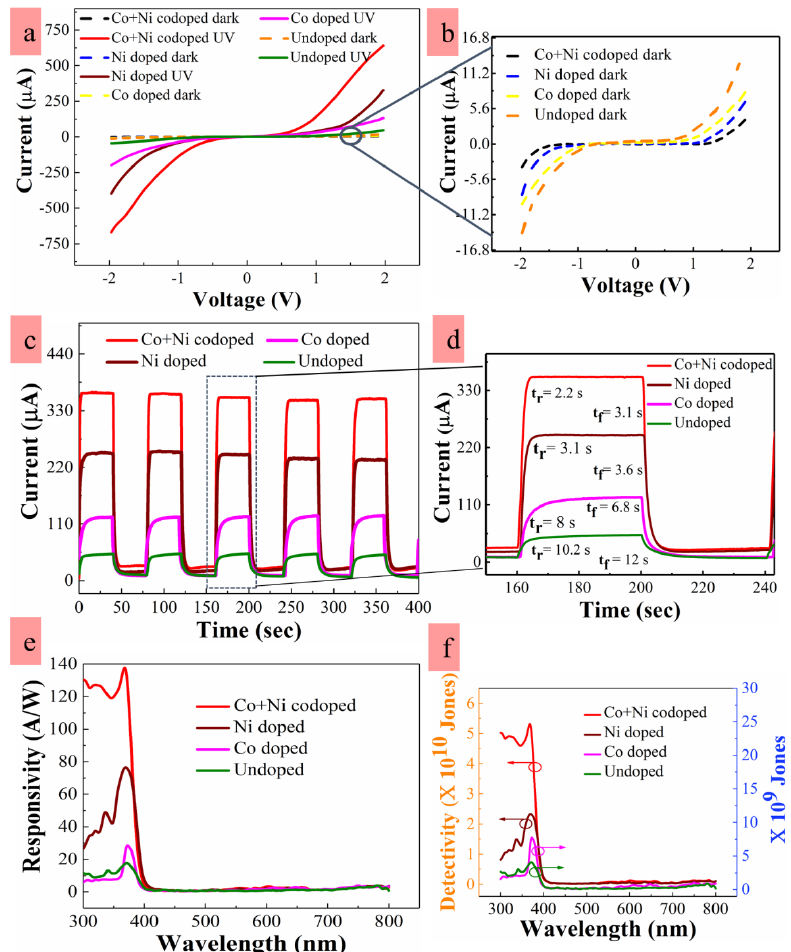
Figure 7. ( a ) Current-voltage ( I – V ), ( b ) expanded view of I – V characteristics in the dark condition, ( c ) transient responses, ( d ) expanded view of single transient cycle, ( e ) spectral responsivities, and ( f ) specific detectivity of PDs.